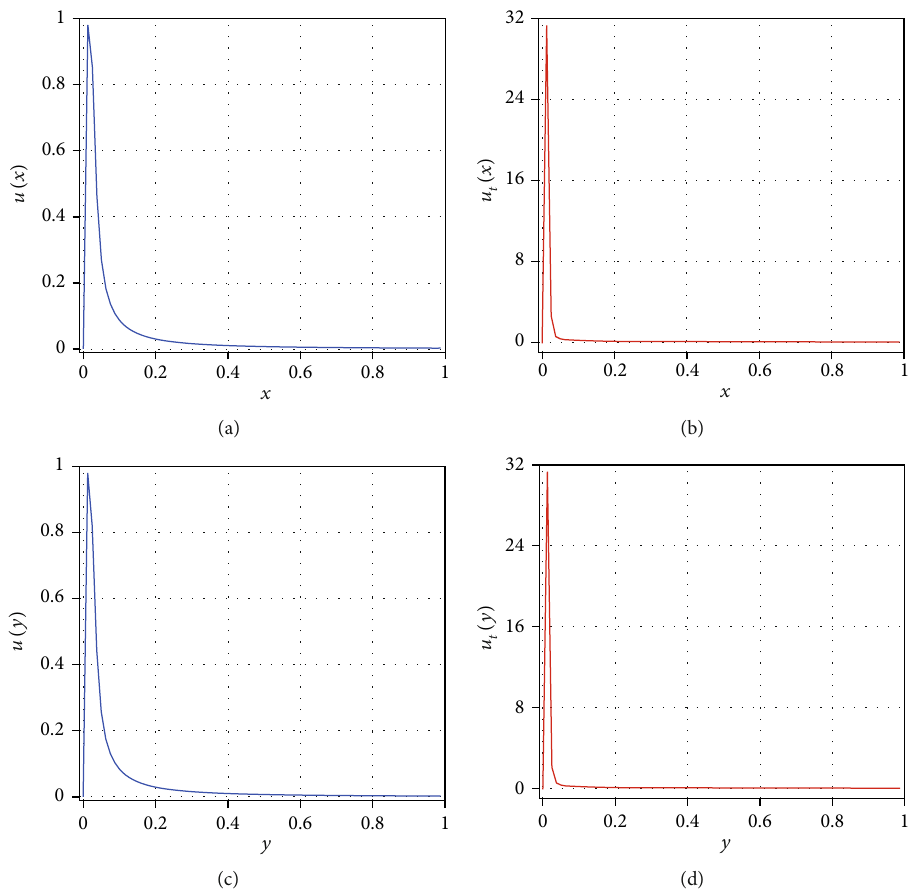
x increases, (c) u as y increases, and (d) u t as